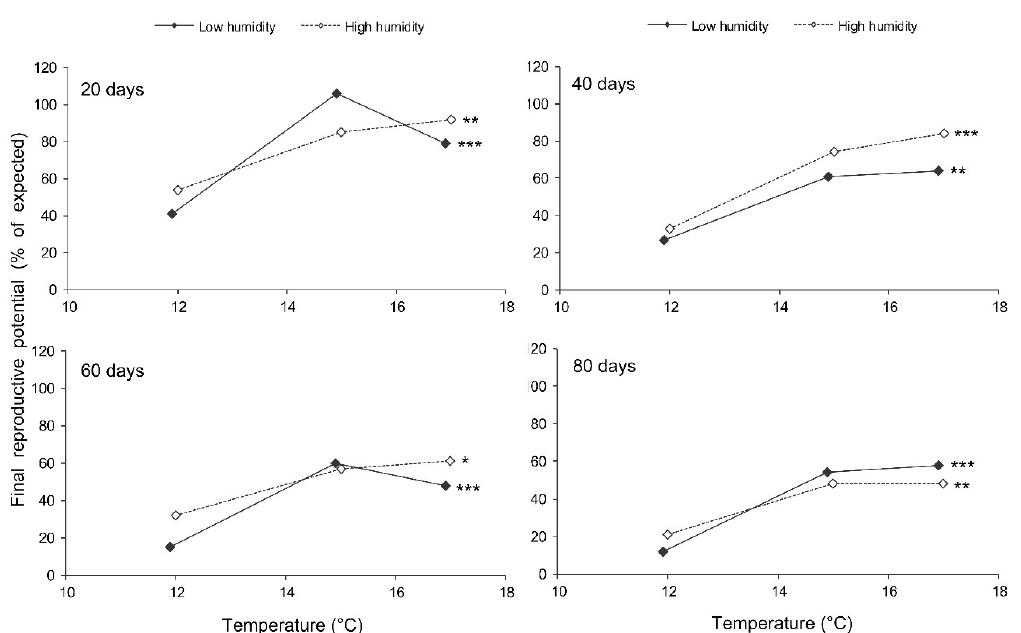
Figure 8. Final reproductive potential of Cheilomenes propinqua females in relation to the temperature, humidity, trophic regime, and duration of storage (the results of the short-term experiment). Asterisks at the right end of the line indicate a significant influence of temperature: *— p < 0.05, **— p < 0.01, ***— p < 0.001, according to the Kruskal–Wallis test. Plus symbols indicate a significant influence of the trophic regime at the corresponding temperature: ++— p < 0.01, +++— p < 0.001, according to the Kruskal–Wallis test. X-crosses indicate the significant influence of humidity at the corresponding temperature: ×— p < 0.05 according to the Kruskal–Wallis test.